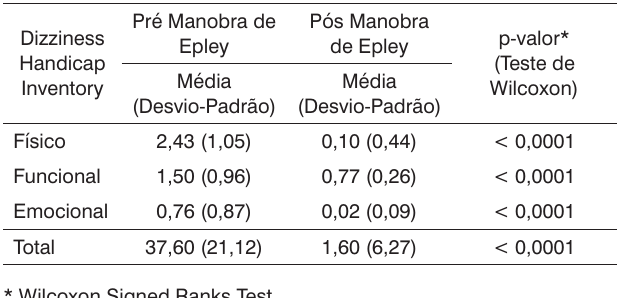
Tabela 1. Valores das médias e desvio-padrão e nível descritivo